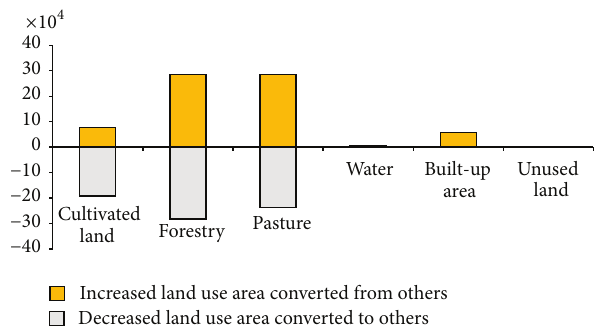
Figure 2: Area changes of major land use types in Yunnan province during 1985–2008.